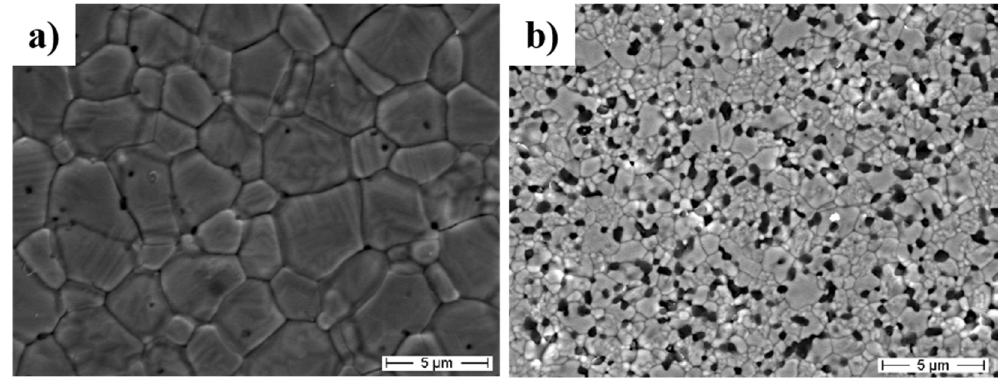
Figure 7. FESEM micrographs of ( a ) pure CeO 2 -stabilized ZrO 2 and ( b ) the respective composite containing 16 vol. % of α -Al 2 O 3 , both sintered at 1450 °C for 1h